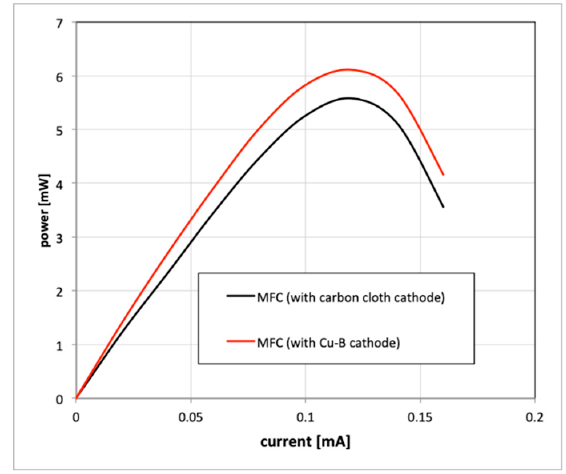
Figure 13. Power curves of the MFC: effect of the cathode material.